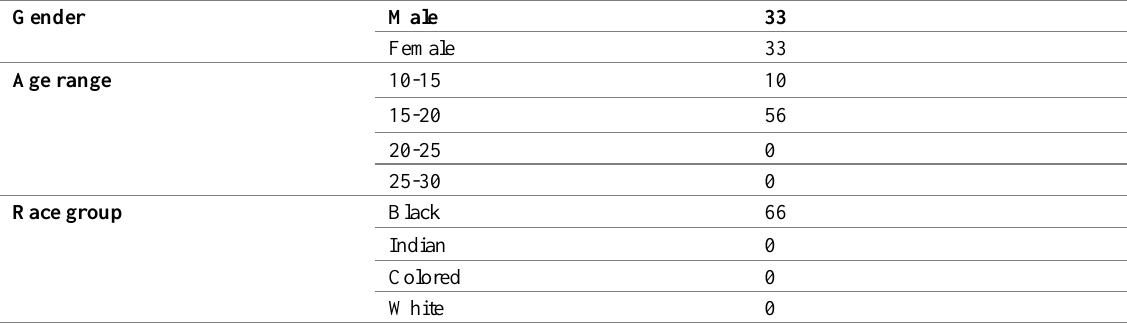
Table 1: Demographic profile of the participants